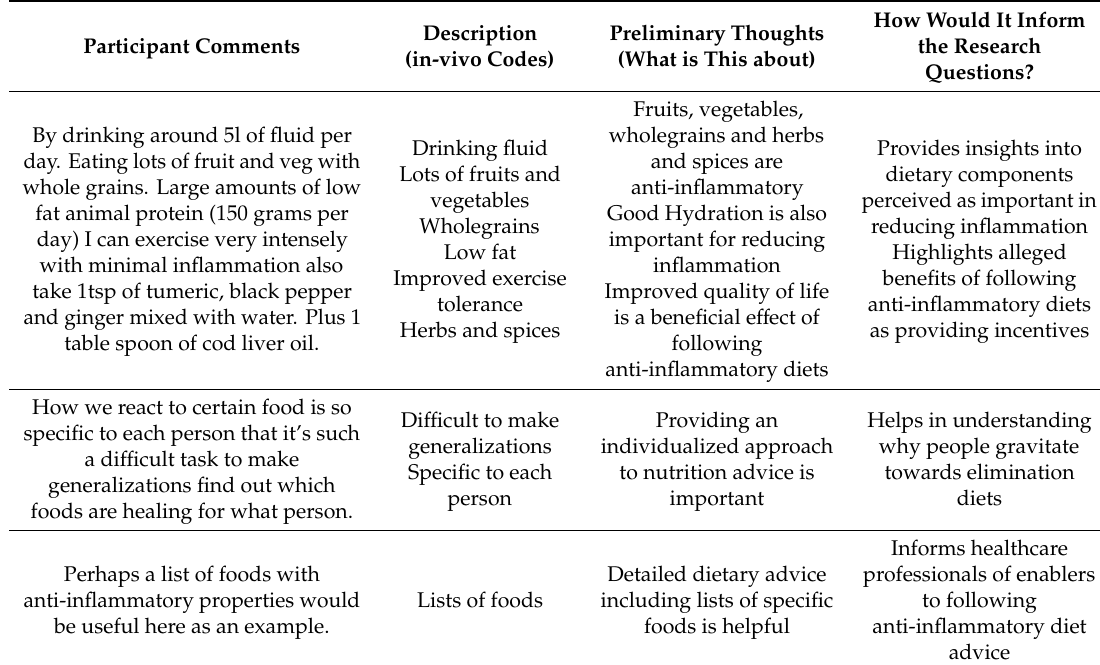
Table A2. Sample of the initial inductive coding